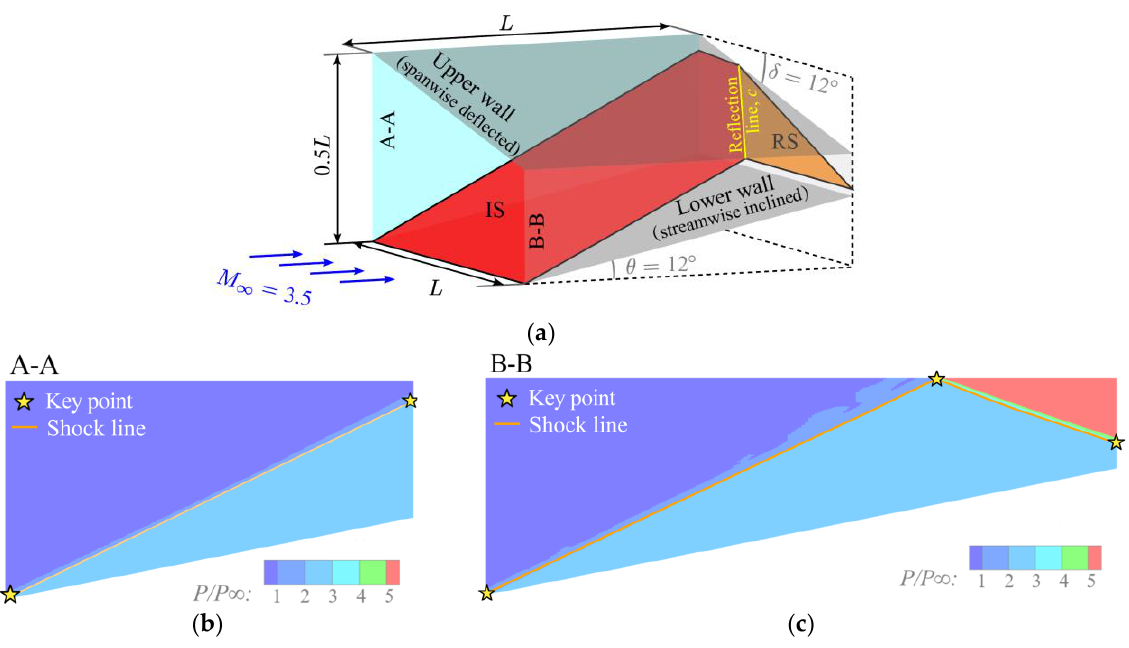
Figure 7. Planer shock with regular reflection on a side inclined wall: ( a ) illustration of the shock wave structure and the calculation domain, ( b , c ) two-dimensional shock topology recognition results and pressure contours in side boundaries A-A and B-B.